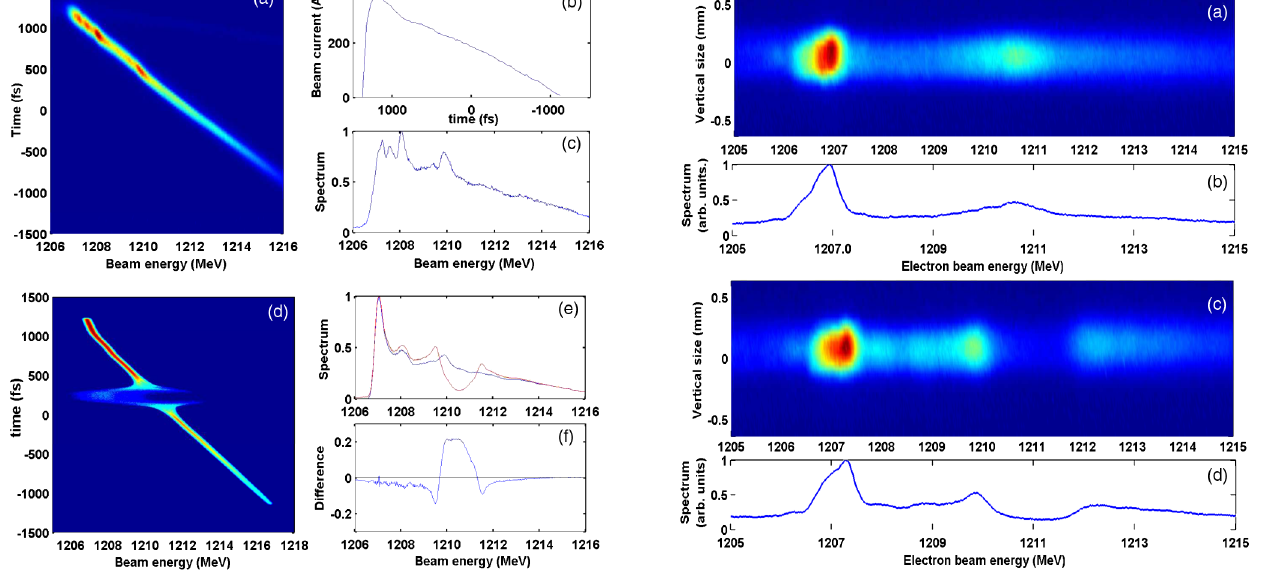
FIG. 2 (color online). Longitudinal phase space measured in DBD with the rf deflector (a), current profile (b), and energy spectrum (c) of the electron beam at the end of the LINAC before entering the undulators. Panels (d), (e), and (f) display numerical simulation results that have been done using the measured electron-beam properties. Panel (d) reports the phase space at the exit of the last radiator clearly showing the strong energy modulation in the spectrum. Panel (e) plots the electron-beam energy spectrum with (red) and without (blue) the seeding. Panel (f) reports the difference between the two.